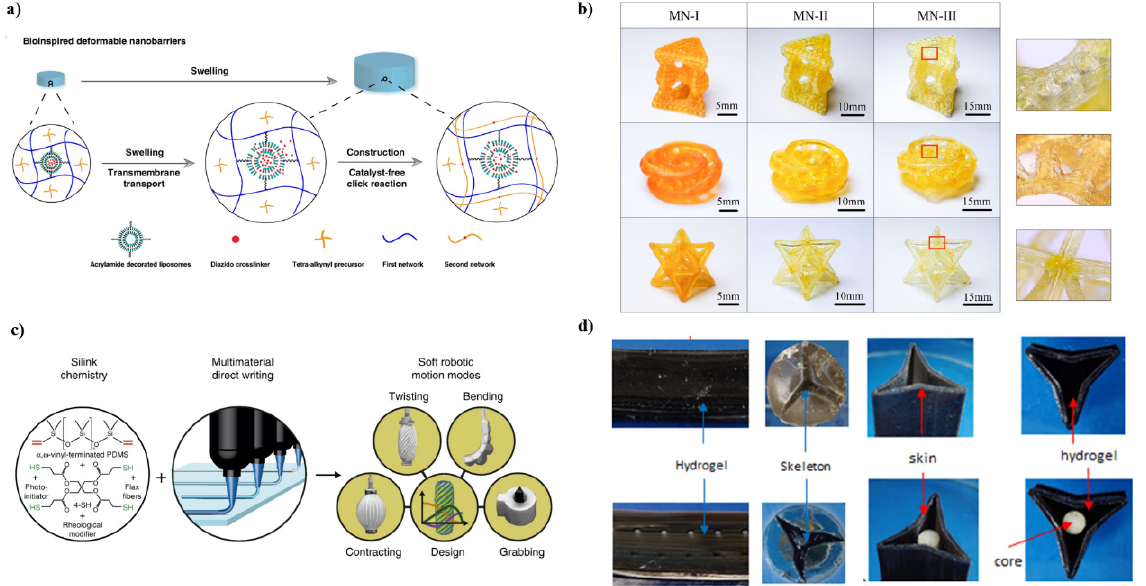
Figure 2. ( a ) Diffusion-inspired transport across synthetic liposome membranes by biological mem- branes. Reproduced with permission from ref. [53]. Copyright 2020, Springer Nature. ( b ) Self-grown multinetwork (MN) complex structures composed of Mobius shells, Kagome lattices, and octet lattices were fabricated by 3D printing. Reproduced with permission from ref. [54]. Copyright 2022, Elsevier. ( c ) Light-curable silicone inks have variable stiffness; multi-materials 3D printing with different stiffness in a single print with seamless combines can be obtained via precise programming. Reproduced with permission from ref. [55]. Copyright 2018, Springer Nature. ( d ) The left two columns are hydrogel–elastomer combined multi-material structures, and the right two columns are artificial cactus shapes. Reproduced with permission from ref. [56]. Copyright 1969, Elsevier.